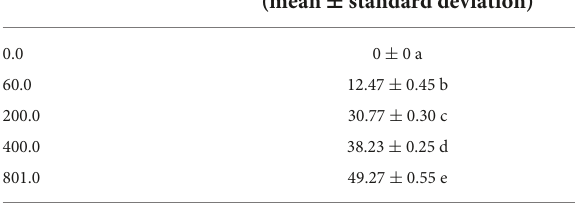
TABLE 1 Inhibitory effects of copper sulfate solution at different Cu 2 + concentrations (0.0, 60.0, 200.0, 400.0, and 801.0 mM) on the mycelium growth of Plenodomus tracheiphilus Pt 42, as determined with the agar diffusion test by measuring the diameter of the inhibition halo around the wells, after 3 days of incubation at 25 ◦ C.